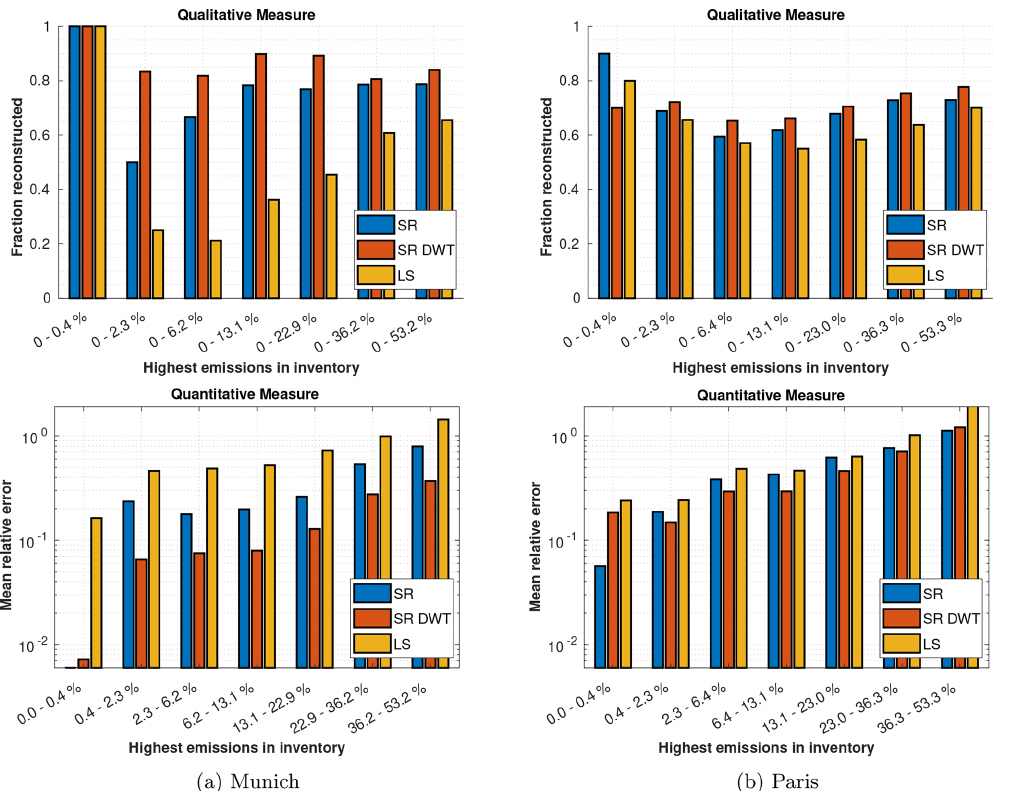
Figure 7. Qualitative and quantitative measure of how well SR and LS estimate the highest emissions for (a) Munich and (b) Paris.